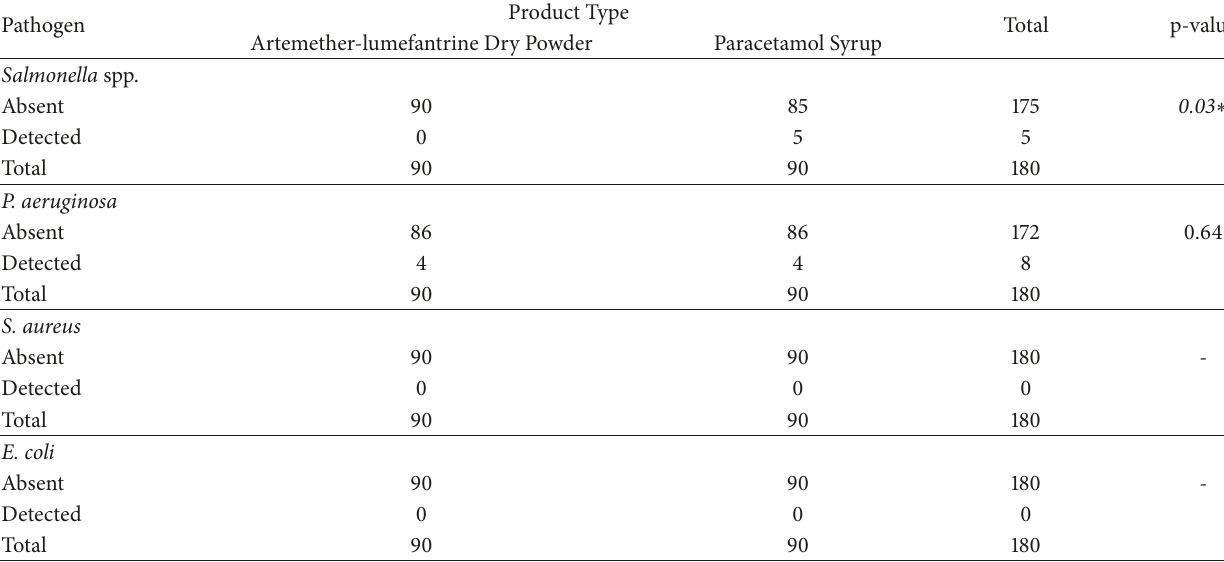
Table 3: Associations between product type and presence of pathogens.